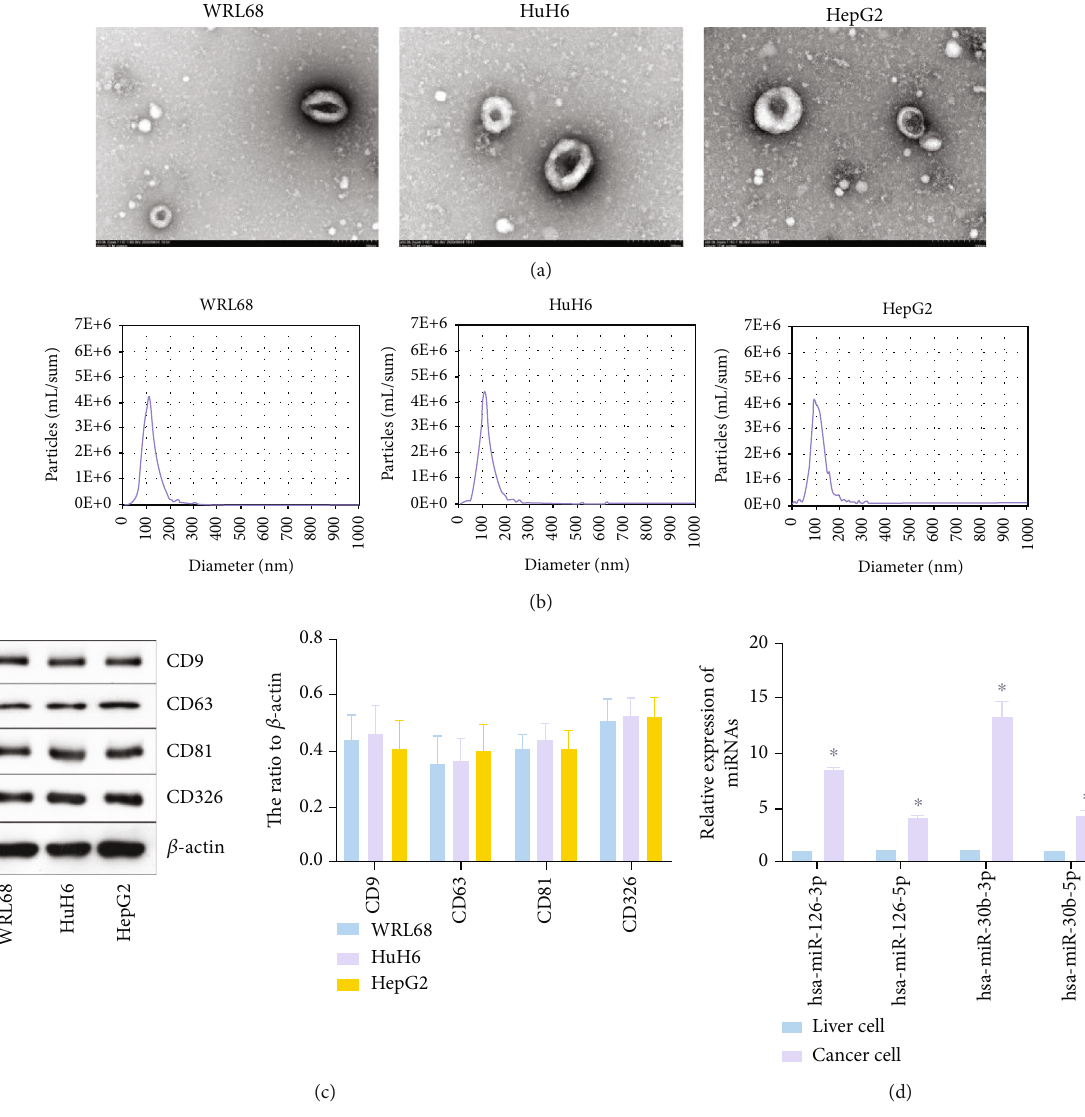
Figure 2: miR-126 was upregulated in cancer cells. (a) The separation e ffi ciency of EVs was examined by TEM. (b) The particle sizes of EVs derived from hepatoblastoma and normal liver cells were measured by NTA. (c) The expressions of CD9, CD63, CD81, and CD326 in hepatoblastoma cells were assessed by western blotting. β -Actin was applied for normalization. (d) The expressions of miR-126-3p, miR-126-5p, miR-30b-3p, and miR-30b-5p in liver or cancer cells were detected by RT-qPCR. ∗ P < 0 : 05 compared to liver